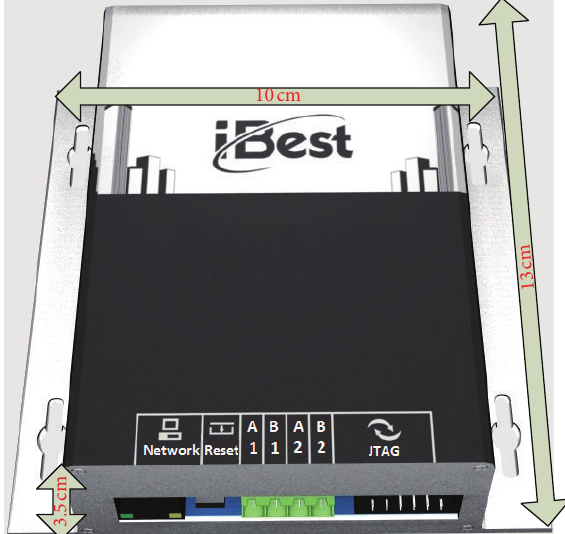
Figure 2: An actual photograph of the collector.